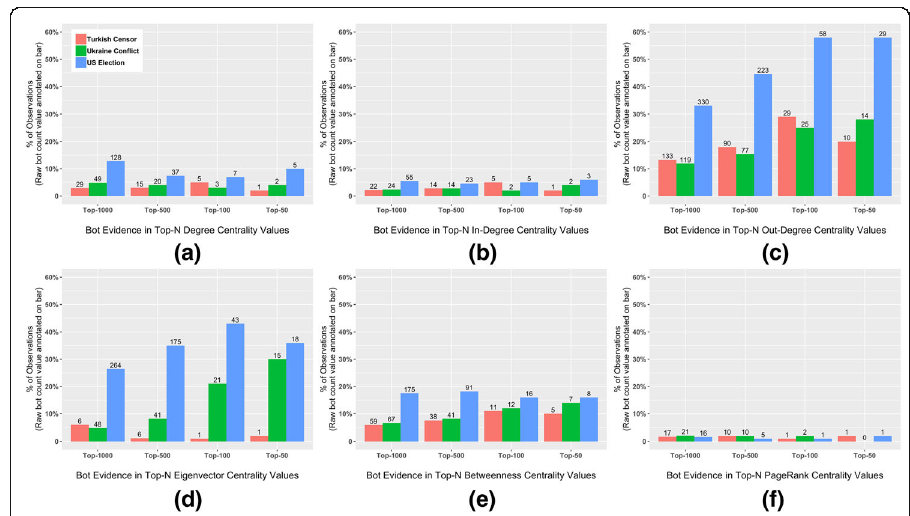
Fig. 4 Social bot user evidence within the Top- N (where, N = 1000 / 500 / 100 / 50) [( a ) degree ( b ) in-degree ( c ) out-degree ( d ) eigenvector ( e ) betweenness ( f ) PageRank] centrality rankings for the U.S. Election ( blue ), the Ukraine Conflict ( green ) and the Turkish Censorship ( red ) OSN conversations. Each bar chart represents the total social bot percentage of the range of accounts with a raw social bot account atop each